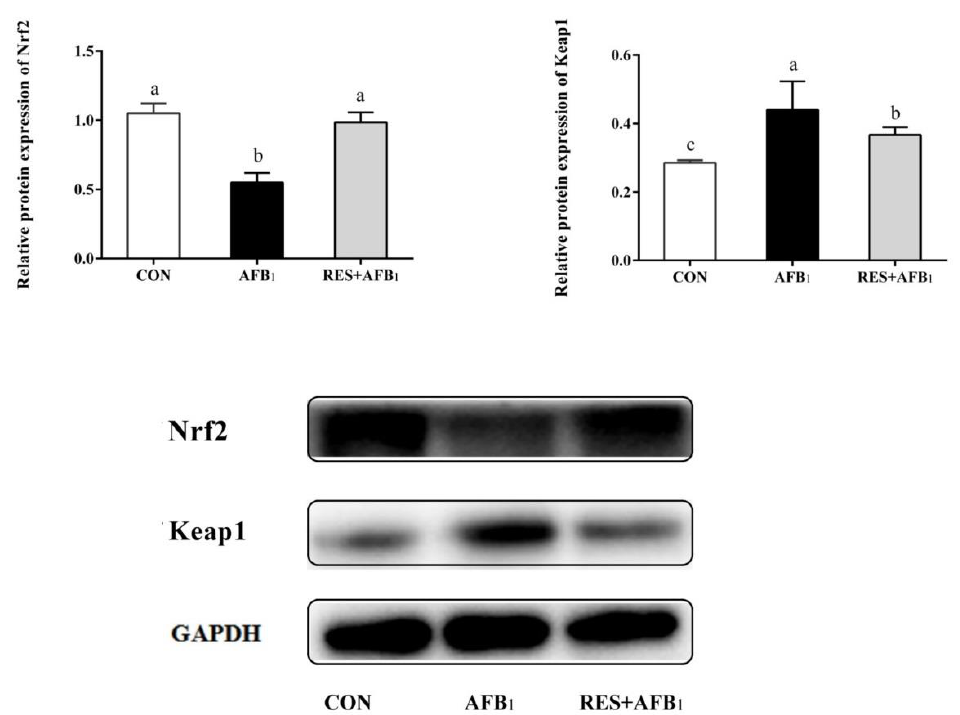
Figure 4. Effect of RES on protein expression of Nrf2 and Keap1 in the ileum of AFB 1 -exposed duck. Values are expressed as mean ± SD, n = 8. Labeled (a, b, c, a > b > c) means in a row without a common letter differ, p < 0.05. Nrf2: Nuclear Factor E2-related Factor 2; Keap1: Kelch-like ECH-associated protein 1; GAPDH: Glyceraldehyde-3-phosphate dehydrogenase; CON: Control group; AFB 1 : AFB 1 group; RES+ AFB 1 : RES+ AFB 1 group.